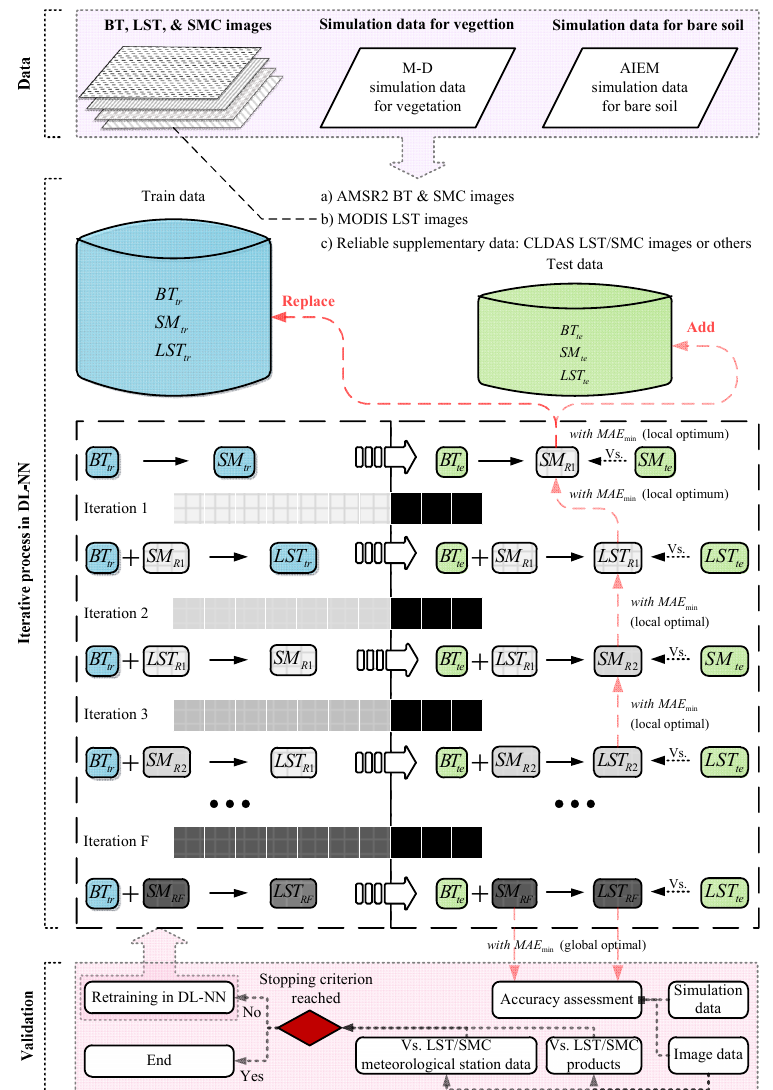
Figure 3. The iterative computing flow of SM and LST.